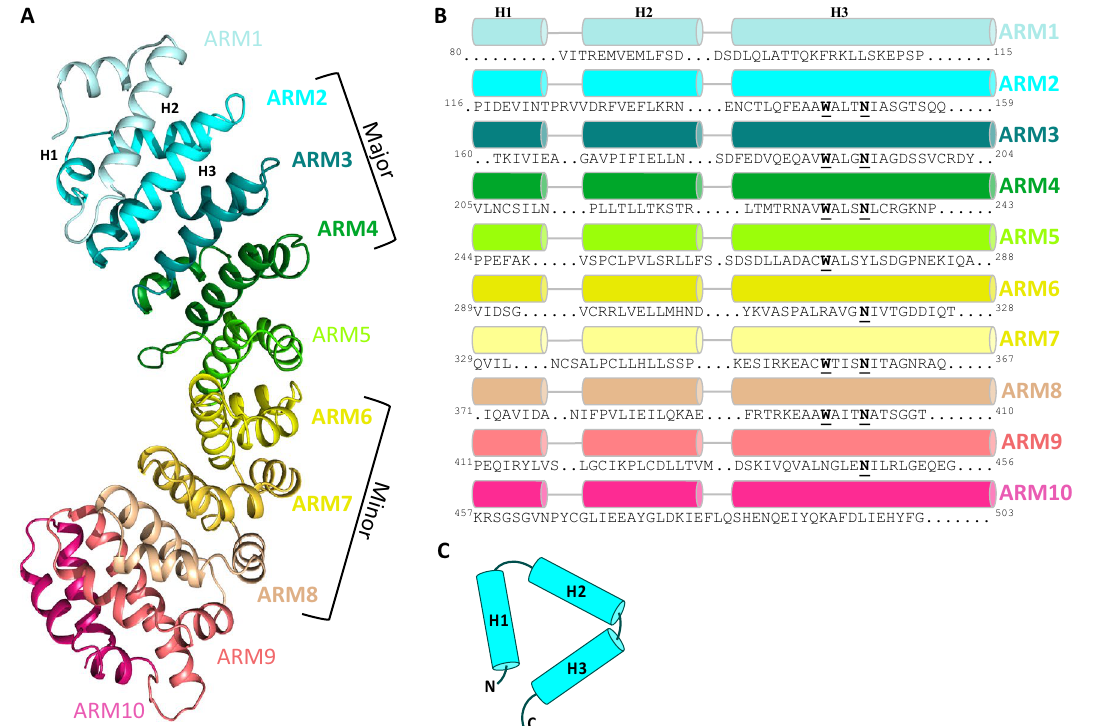
Figure 1. ( A ) Structure of IMPα7 ARM domains resolved to 2.5 Å resolution in cargo-free form shown in ribbon-cartoon format containing 10 ARM-repeats. ( B ) IMPα7 ARM domain structure-based sequence alignment with α-helices shown as colour-coded cylinders matching panel ( A ), with structural repeat H1, H2 and H3 indicated at the top. The residue numbers are shown in the beginning and at the end of each repeat. Presence of highly conserved Trp and Asn residues highlighted in bold and underline. ( C ) Each ARM repeat consists of three alpha helices: H1, H2 and H3, forming a stable triangular